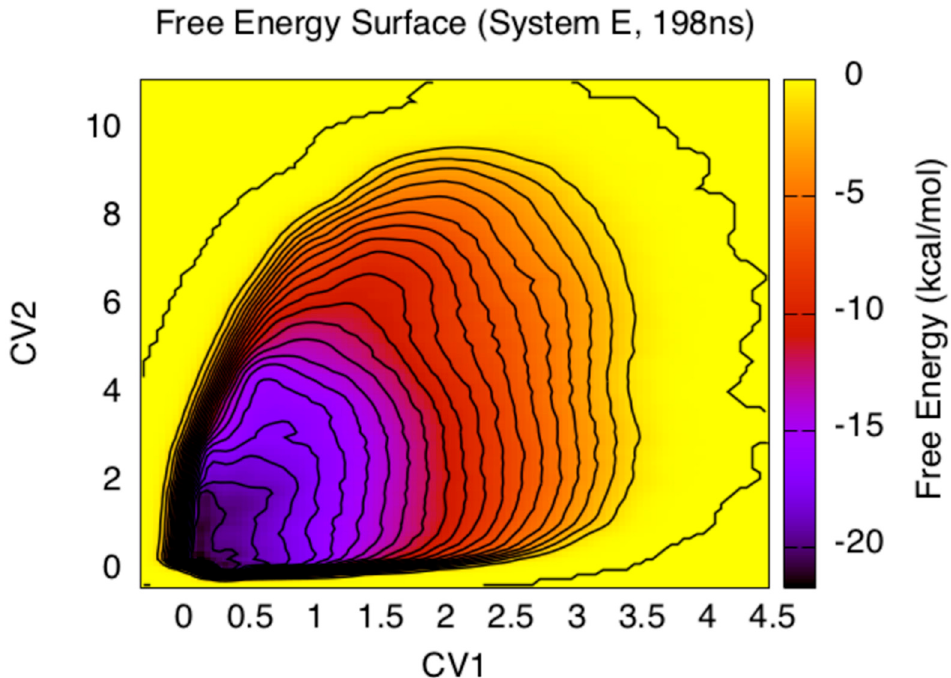
Figure 9. The 2D free energy surface contour plot for system E involving DP 10 PIL and DP 10 cellulose in water. CV1 and CV2 represent the numbers of hydrogen bonds formed between them.